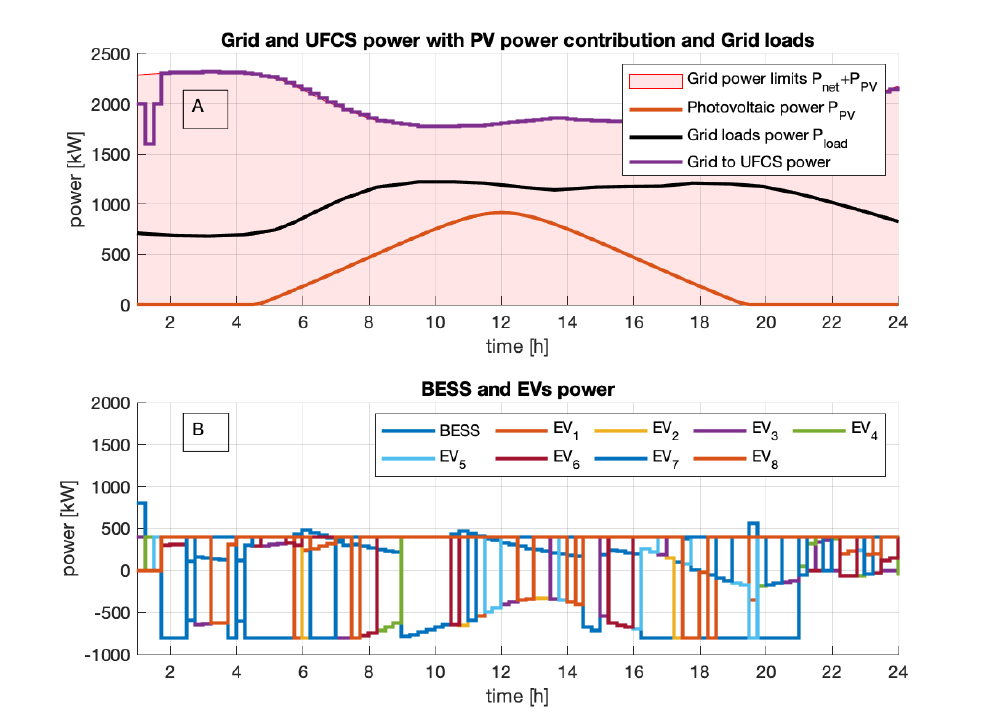
Figure 6. Subplot ( A ) shows the grid power limit, photovoltaic power contribution, and load power. The magenta colour indicates the UFCS power. Subplot ( B ) shows the details of the BESS and EVs